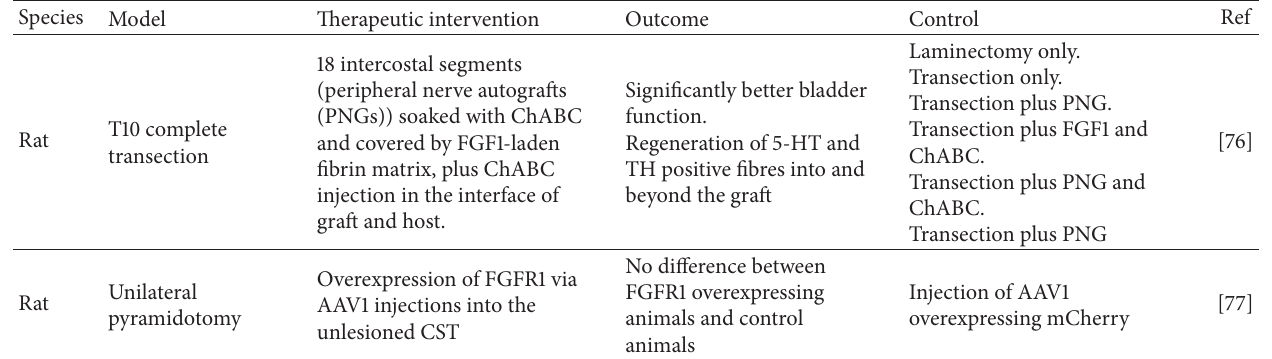
Table 3: Combination